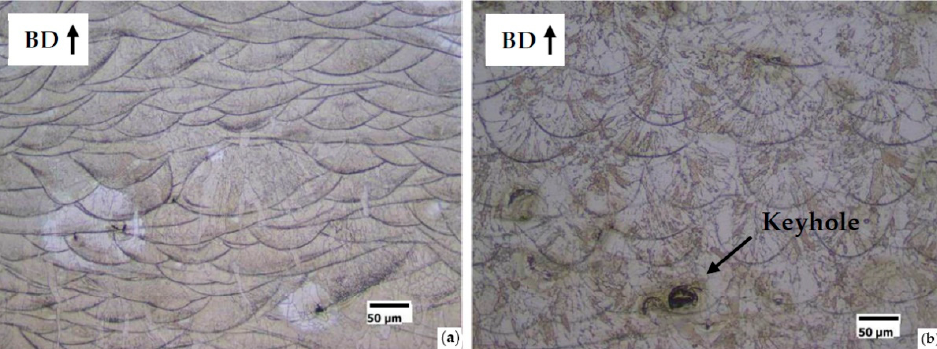
Figure 8. Example of transition from conduction melting to keyhole formation. ( a ) optical micro- graph of the longitudinal section to the build direction (BD) of S1-FeSi6.5 sample ( E = 150 Jm − 1 , v = 0.5 ms − 1 , P = 75 W), conduction melt mode; ( b ) optical micrograph of the longitudinal section to the build direction (BD) of S18-FeSi6.5 sample ( E = 350 Jm − 1 , v = 0.5 ms − 1 , P = 175 W), keyhole mode.